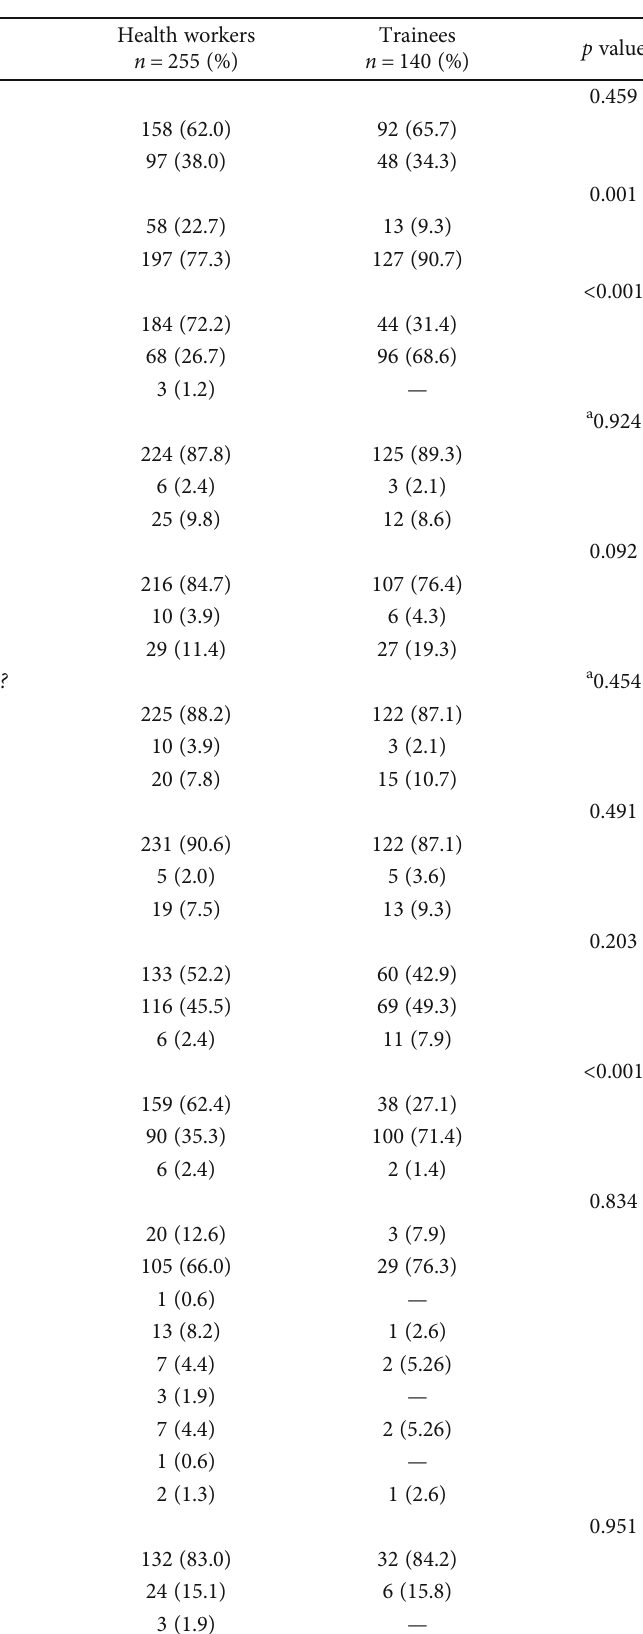
Table 4: Comparison of attitudes and practices regarding contraceptive use between health workers and